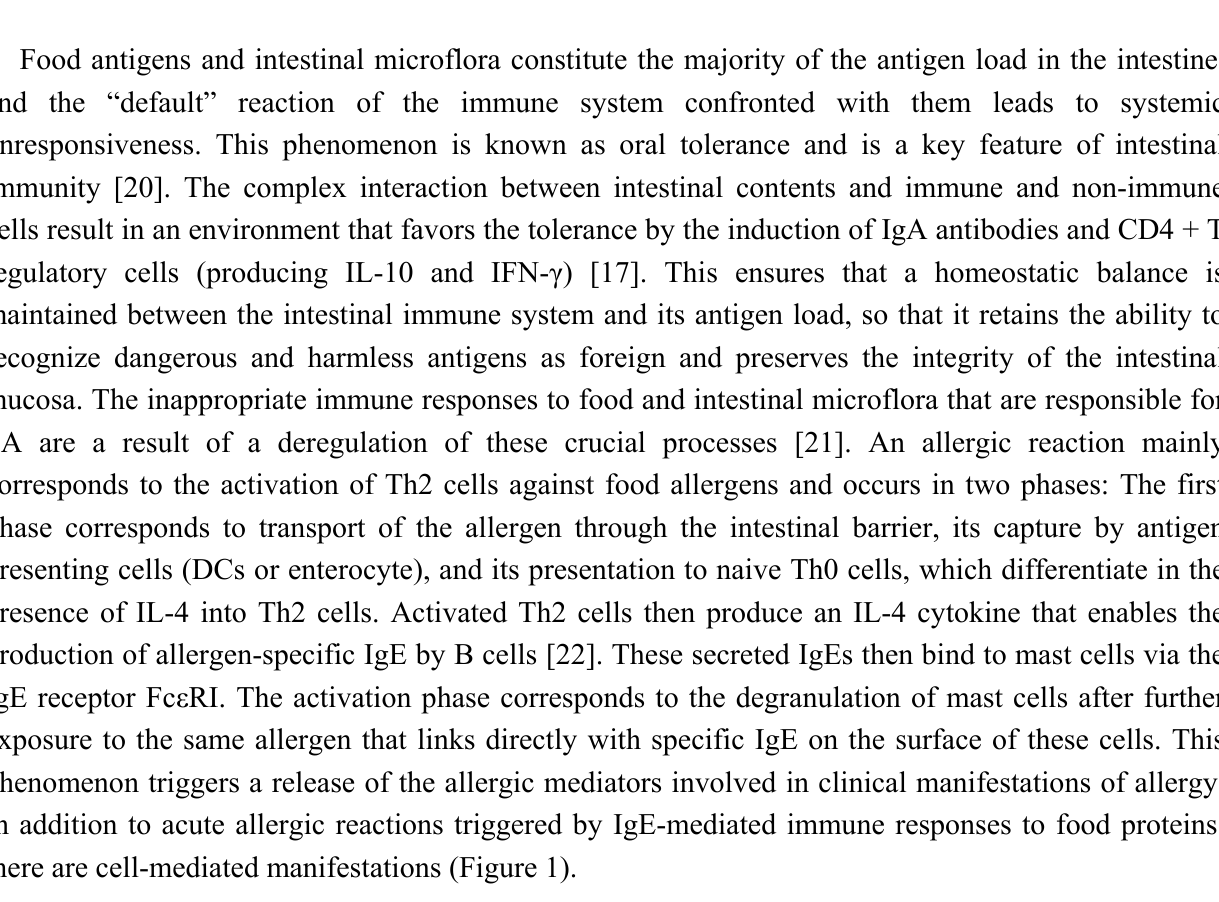
Figure 1. Lactobacillus GG acts on different mechanisms of